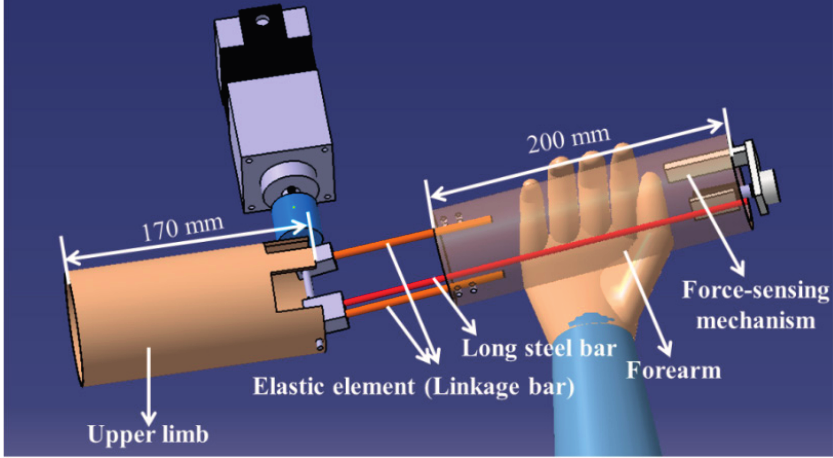
Figure 4. Prototype of the master device ( i.e. , a human-upper-limb-like